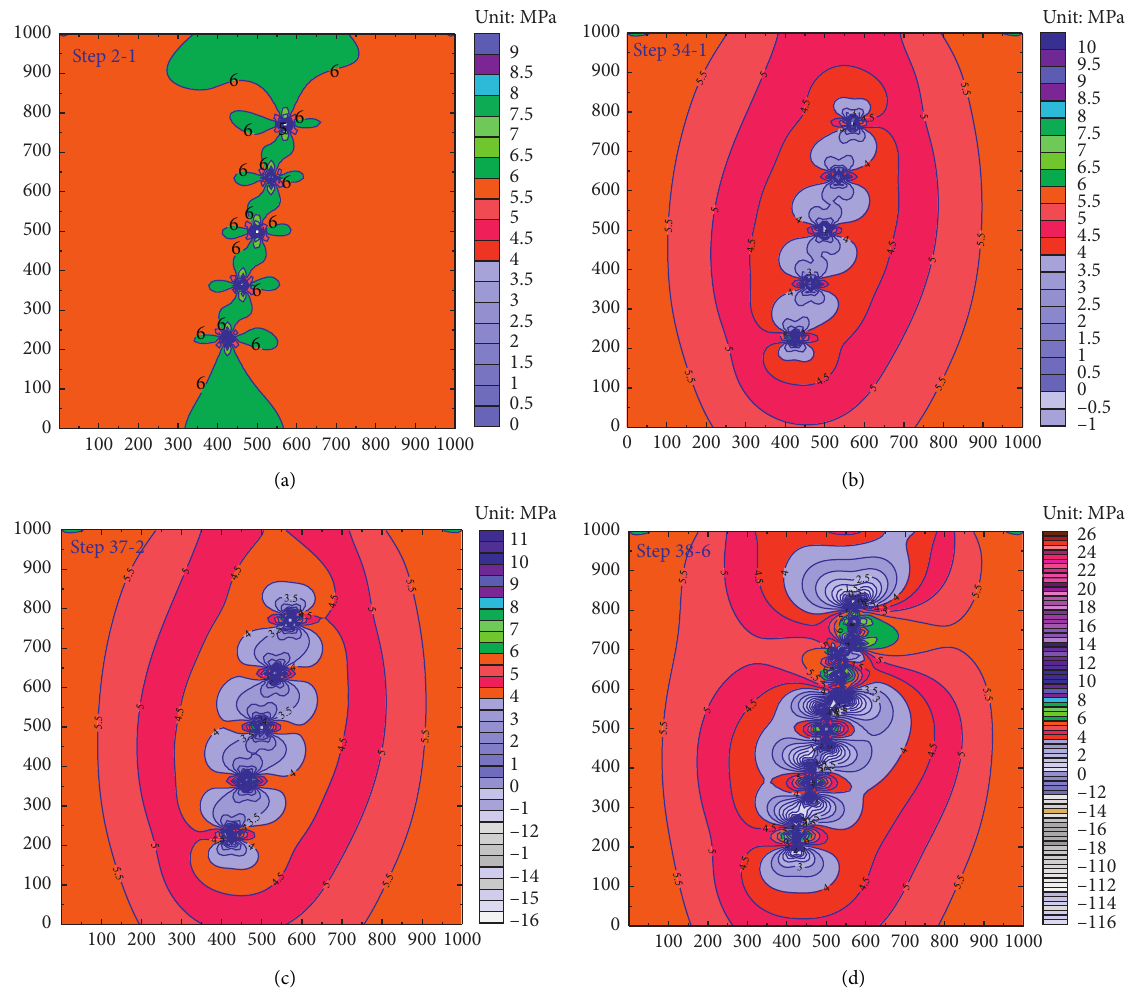
Figure 9: The variation of horizontal poroelastic stress contour during hydraulic fracturing.